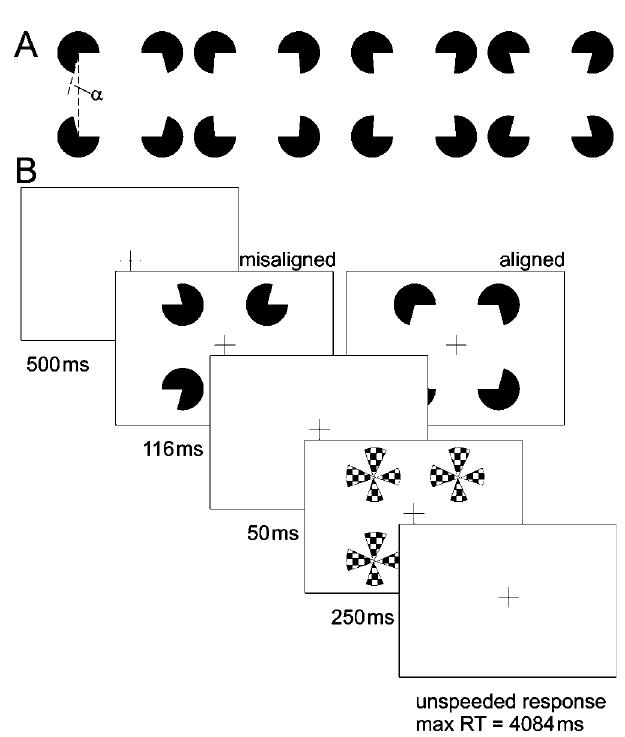
Figure 1. Experimental stimuli and trial. (A) Kanizsa stimuli consisted of four inducers (note that stimulus depictions in the manuscript are contrast reversed), with openings (alpha) varying between ± 15 around 90 ° . Openings larger than 90 ° resulted in convex shapes (two left-hand fi gures) and those smaller than 90 ° in concave shapes (two right hand fi gures). The ease of curvature discrimi- nation depended on the magnitude of alpha. Large values resulted in pronounced curvature (outermost stimuli), whereas curvature was hardly detectable for small alpha, (innermost stimuli). (B) Participants performed the task inside the scanner. They were required to fi xate the central cross during the entire experi- ment. Inducers (aligned or misaligned) were presented for 100 ms followed by a 250 ms presentation of a mask stimulus after an intervening blank period of 50 ms. Participants were required to discriminate between convex and concave shapes by pressing the right or left response button, respectively, within the remaining inter trial interval of 4084 ms. Auditory feedback (1000 Hz tone of 300 ms duration) followed each correct